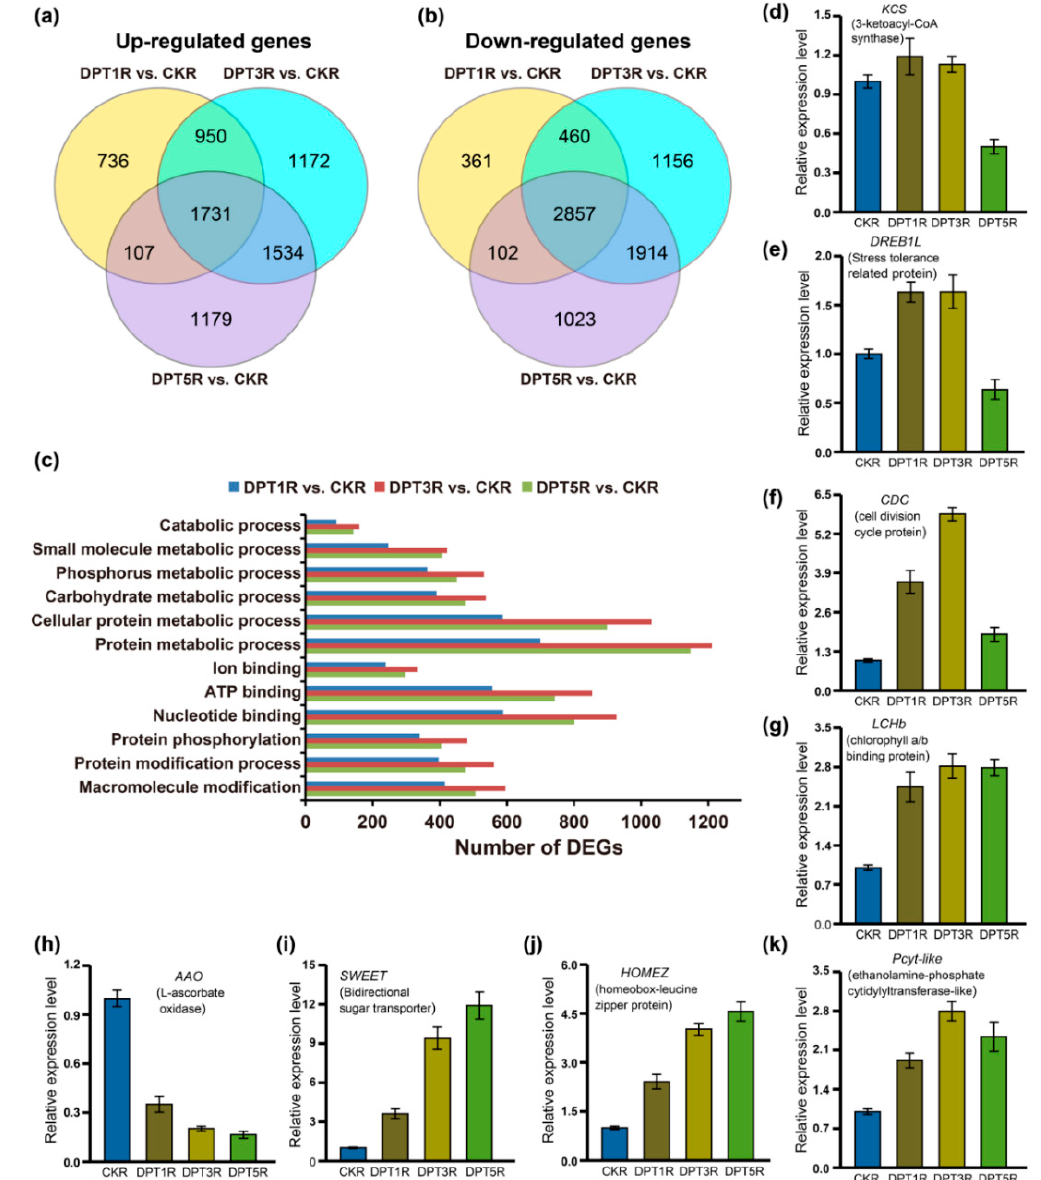
Figure 5. Comprehensive expression patterns of DEGs in the roots of common buckwheat seedlings under drought stress conditions. ( a ) Venn diagrams of the numbers of up-regulated [ | log2 (Fold Change) | > 1 and qvalue < 0.005] genes acquired through the transcriptome analysis. ( b ) Venn diagrams of the numbers of down-regulated genes acquired through the transcriptome analysis. ( c ) Classification of DEGs based on metabolism, binding and modification categories. ( d – k ) Expression profiles of the selected DEGs, KCS ( d ), DREB1L ( e ), CDC ( f ), LCHb ( g ), AAO ( h ), SWEET ( i ), HOMEZ ( j ), Pcyt-like ( k ), determined by qRT-PCR.